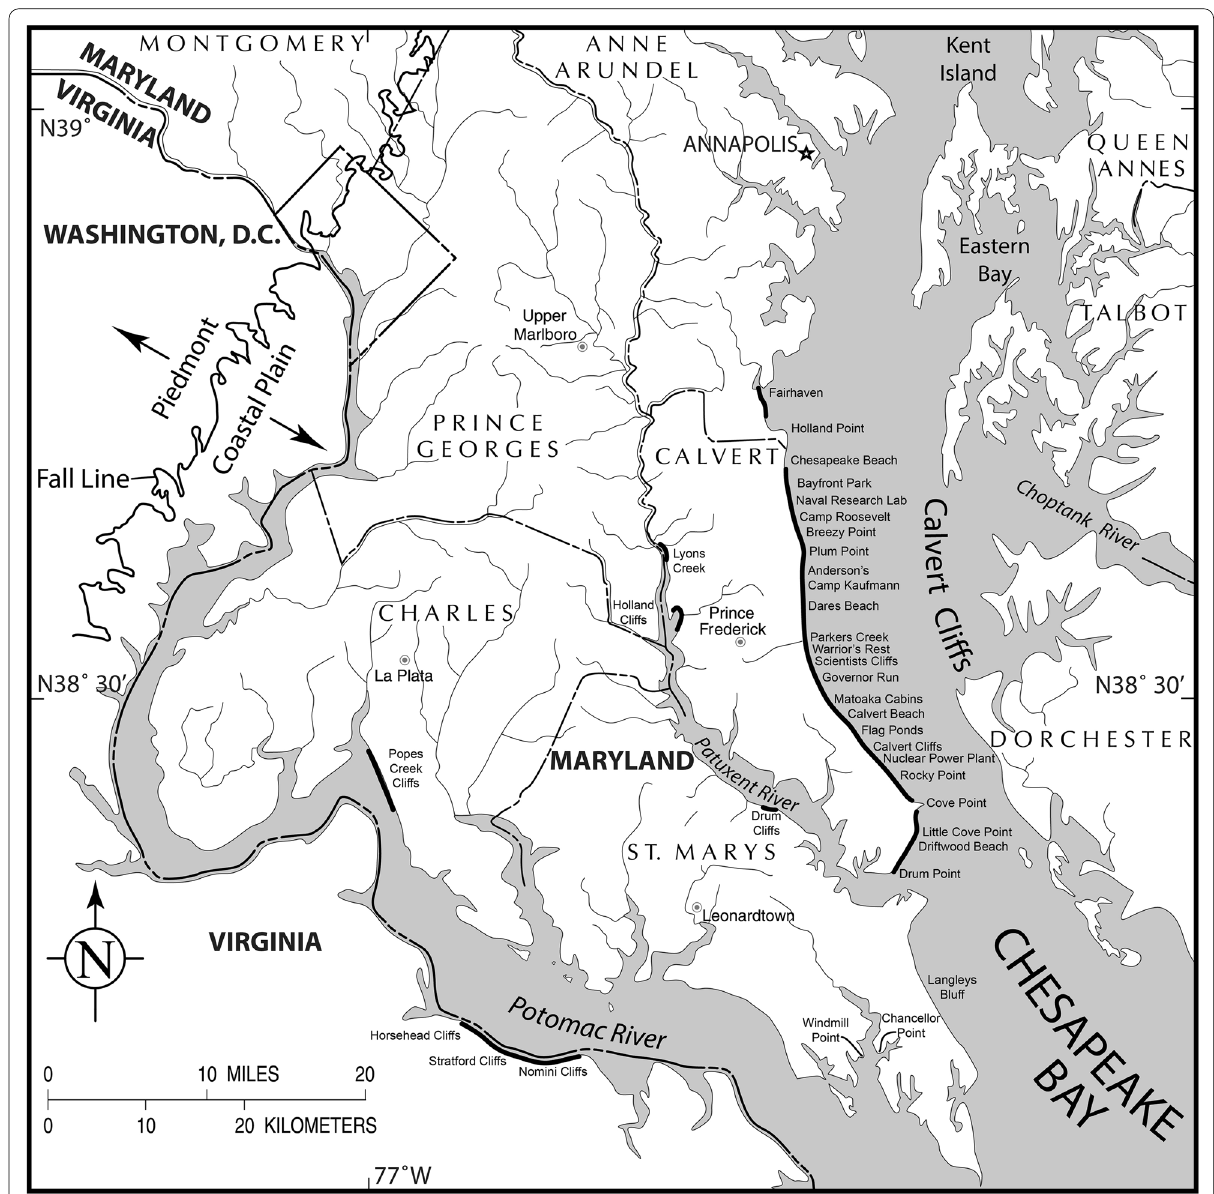
Fig. 1 Chesapeake Bay region, showing Calvert Cliffs—with named states, counties, communities, beaches, and coastal bluffs > 15 m high (i.e., bold black lines). Fall line taken from Powars (2013). Modified from Vogt et al.